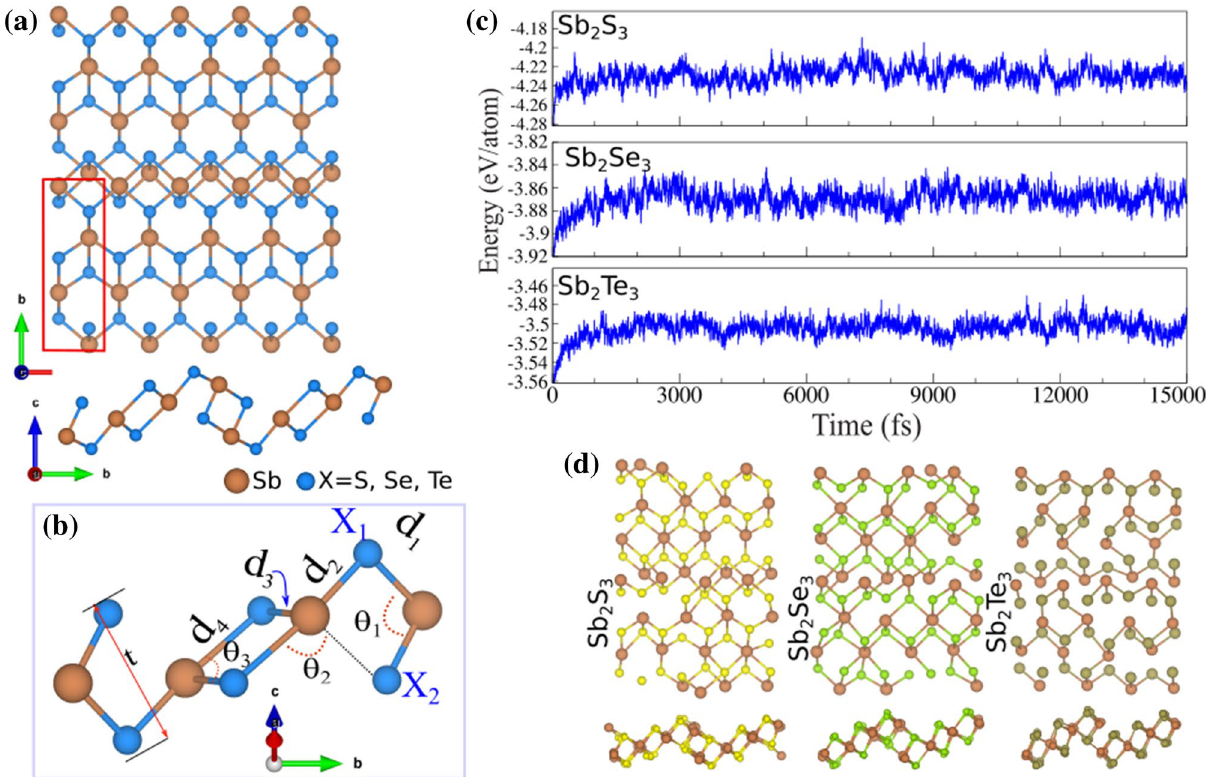
Figure 1. ( a ) Different views of atomic structure of Sb 2 X 3 (X = S, Se, Te) monolayer, with the unit cell distinguished with a rectangle. ( b ) Schematic of structural parameters in a Sb 2 X 3 lattice. ( c ) Ab initio molecular dynamics (AIMD) for these monolayers at room temperature. ( d ) The top and side views of the structures after 5 ps of